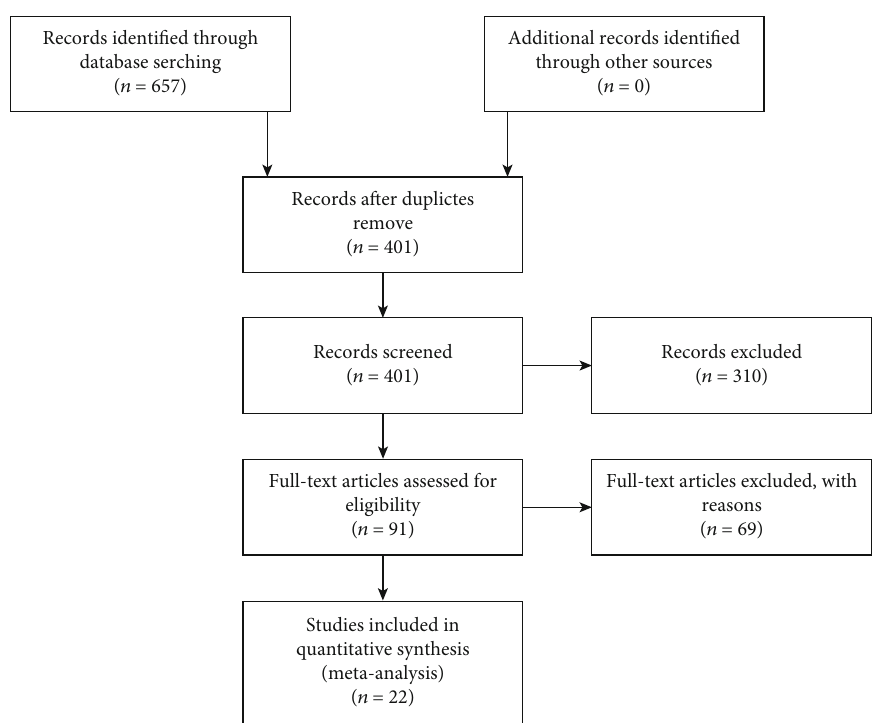
Figure 1: Flow diagram of the systematic